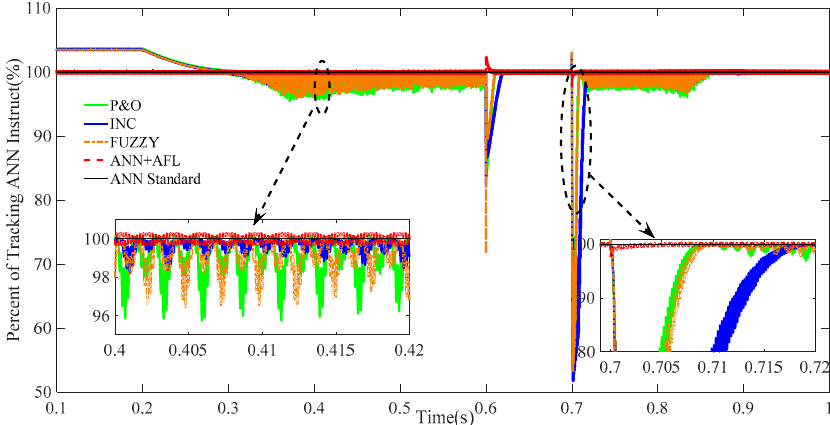
Figure 14. Output power of each method divided by the ANN output power.